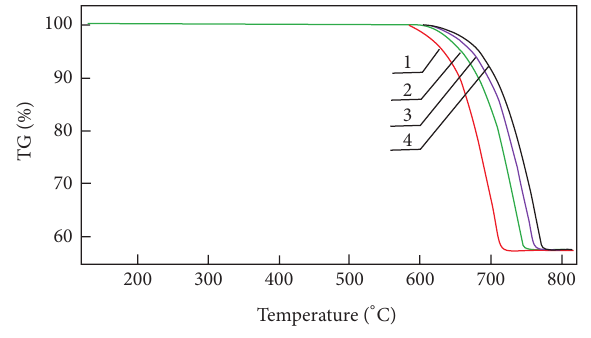
F 4: Dependence of the coefficient of linear regression the values of n in